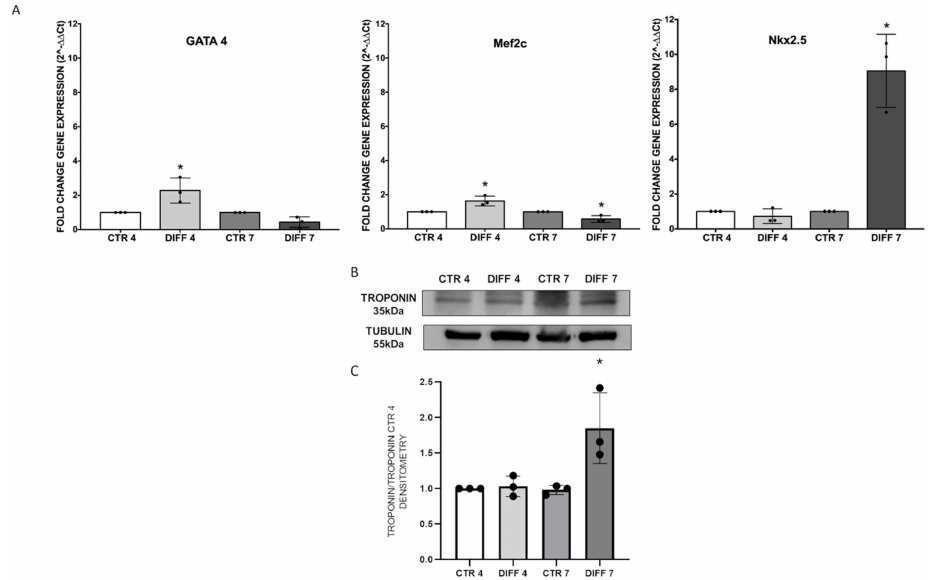
Figure 1. H9c2 myoblast differentiation towards a cardiac-like phenotype after cells were cultured with retinoic acid (RA) for 4 and 7 days. ( A ) The relative gene expression of cardiomyogenic markers GATA 4, Mef2c and Nkx2.5 was assessed by q-RT-PCR. Results were expressed as fold-change ± SD with respect to the untreated cells, obtained in three independent experiments performed in triplicate and analyzed by two-way ANOVA with Bonferroni’s multiple comparison test (* p ≤ 0.05). ( B ) Western blot analysis with mouse anti-cardiac troponin T (cTnT) and anti-tubulin antibodies on H9c2 cell lysates after 4 and 7 days of differentiation. Proteins were revealed on total protein content, and all results were normalized with respect to control at day 4. ( C ) Densitometry results obtained from three different experiments are expressed as mean ± SD. Statistical significance with respect to the relative controls (* p ≤